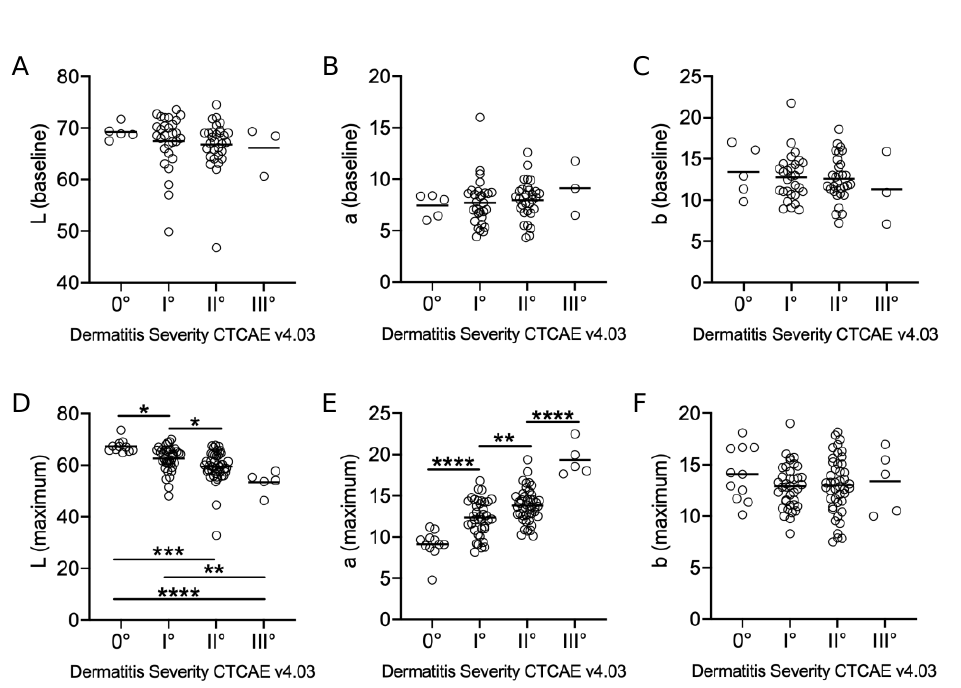
Figure 1. Spectrophotometric assessments of breasts at baseline ( A – C ) and after radiotherapy (RT) completion ( D – F ). All data points are categorized by their final dermatitis severity in accordance with Common Terminology Criteria of Adverse Events (CTCAE). p values were generated using one-way-ANOVA with * for p < 0.05, ** for p < 0.01, *** for p < 0.001 and **** for p < 0.0001. ( A ) Summary p -value determined by ANOVA was 0.73 (not significant). ( B ) Summary p -value determined by ANOVA was 0.68 (not significant). ( C ) Summary p -value determined by ANOVA was 0.77 (not significant). ( F ) Summary p -value determined by ANOVA was 0.55 (not significant). Median of individual groups depicted as a fine horizontal